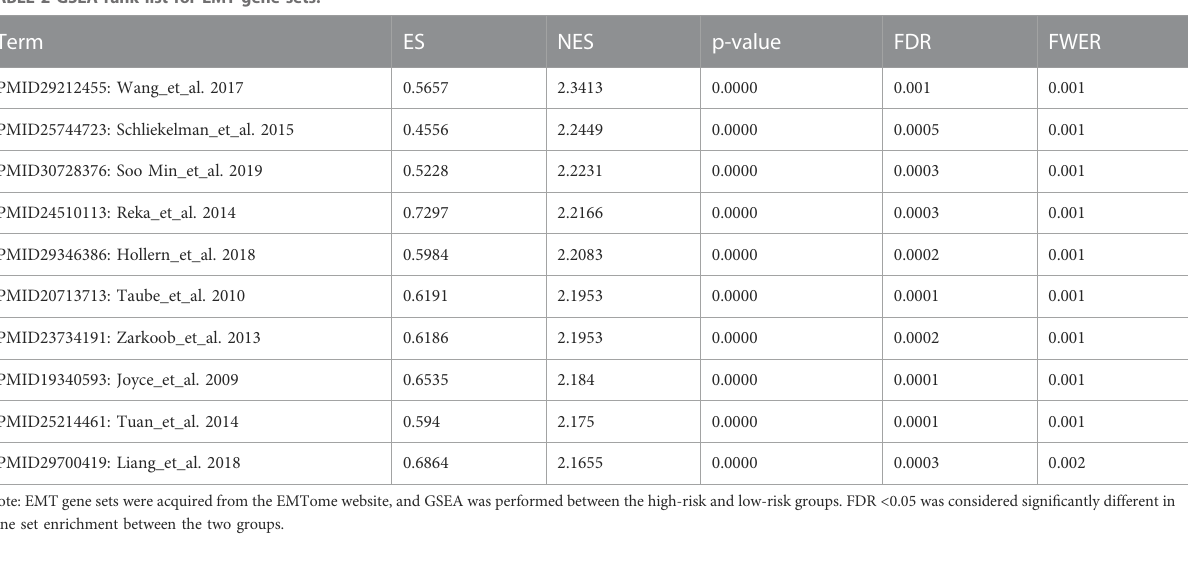
TABLE 2 GSEA rank list for EMT gene sets.